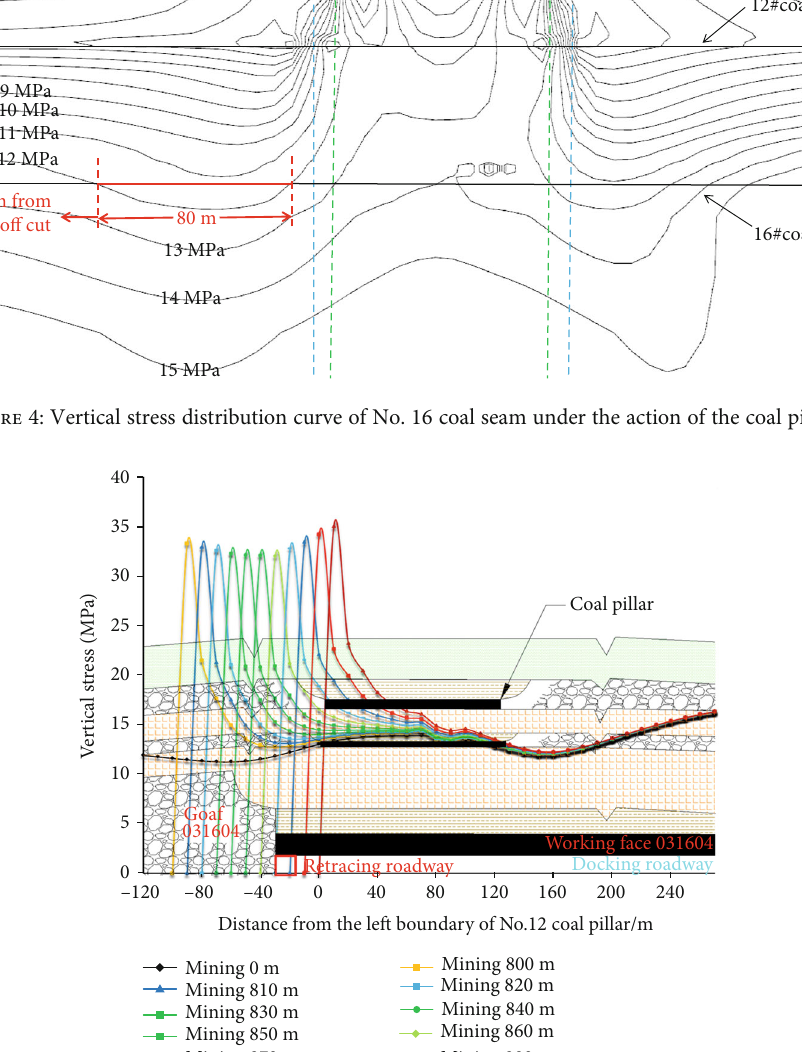
Figure 8. The change of the deviatoric stress of coal pillars on Figure 9, so as to analyze the evolution law of the superimposed